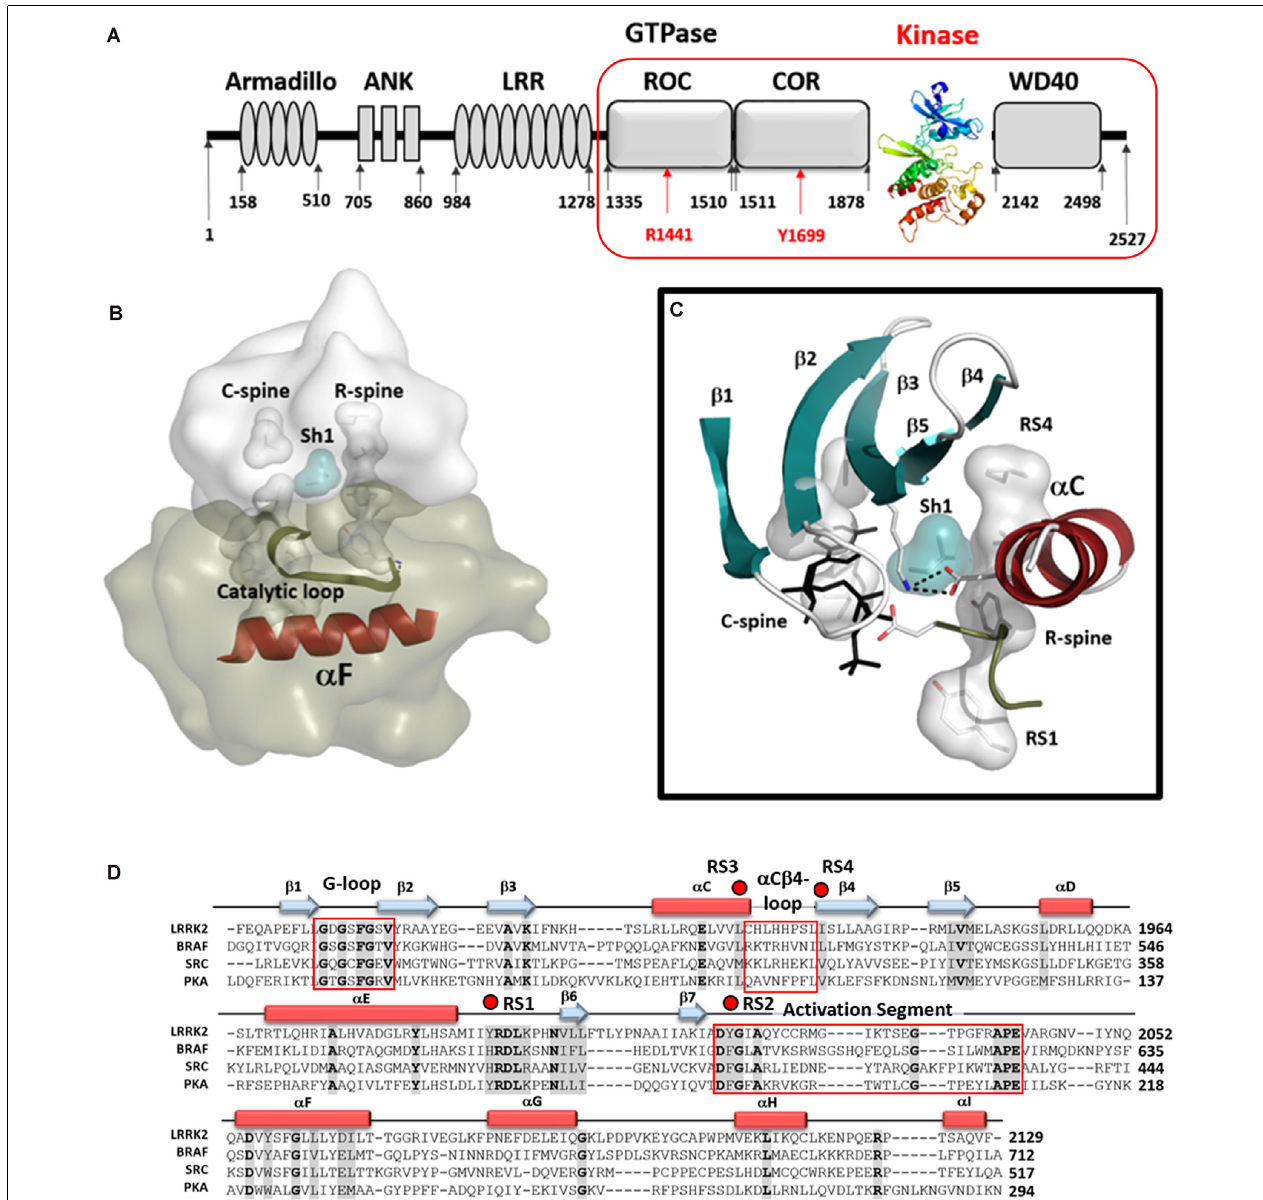
FIGURE 1 | The Kinase domain of Leucine-Rich Repeat Kinase 2 (LRRK2). (A) Organization of the domains of LRRK2 with the kinase domain shown as a ribbon colored from blue at the N-terminus to red at the C-terminus. The Cryo-Electron Microscopy (Cryo-EM) structure of the four C-terminal domains [ROC COR KIN WD40 (RCKW)] construct is indicated by a red box. (B) A model of the active conformation of LRRK2 is shown where the R-spine residues are aligned into an active conformation and both spines as well as the Catalytic Loop are anchored onto the hydrophobic α F-helix. (C) Organization of the N-Lobe in active LRRK2. The five-stranded β -sheet is in teal and the α C-Helix in red. R- and C-spine residues are indicated as shells and the Shell residue (Sh1) that bridges both spines are in teal. The salt bridge between the conserved Lysine in β 3 and conserved Glutamic acid in the C-helix is also shown. (D) The sequences of the kinase domains of LRRK2, BRaf, Src, and PKA are aligned and the regions corresponding to the G-Loop, the α C- β 4 Loop, and the activation segment are highlighted (red boxes). R-spine residues are indicated by red dots. The cartoon indicates the position of β -strands (teal arrows) and α -helices (red